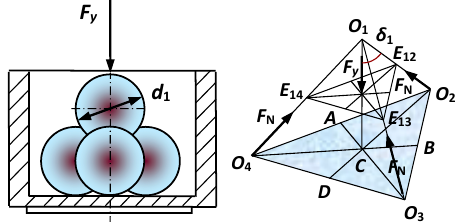
Figure 5. Simplified four-ball mechanical model.